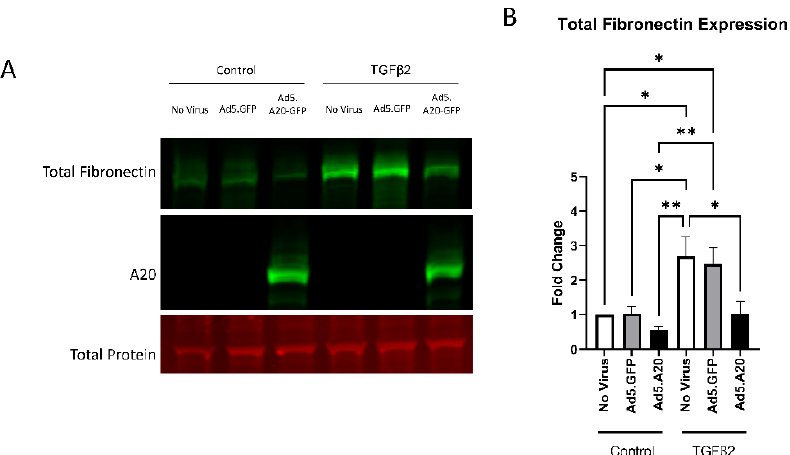
Figure 4. TGF β 2-induced fibronectin expression is attenuated with A20 overexpression. Primary TM cells were treated with the indicated Ad.5 virus and then with TGF β 2 for 48 h. ( A ) Representative Western blot showing fibronectin and A20 expression, with the total protein stain used for normalization. ( B ) Fibronectin expression was greatly induced by the addition of TGF β 2, and A20 overexpression blocked TGF β 2-induced fibronectin expression. Statistical significance was calculated by one-way ANOVA with Tukey post-hoc analysis, with p < 0.05 considered statistically significant. Error bars show SEM. * = p ≤ 0.05, ** = p ≤ 0.01.